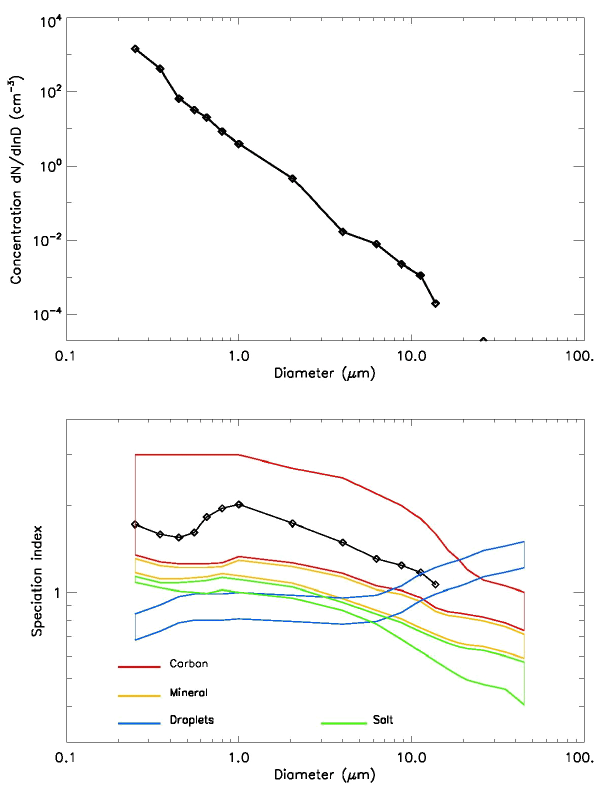
Figure 16. Example of the detection of carbon particles in urban air, in the south-west of Paris on 29 December 2013 around 07:30UT, at the Observatoire Atmosphérique Generali (OAG); upper panel: size distribution; lower panel: typology, the LOAC data are in black dots. The LOAC uncertainties are ± 20% for the higher concentrations and ± 60% for the lower concentrations.